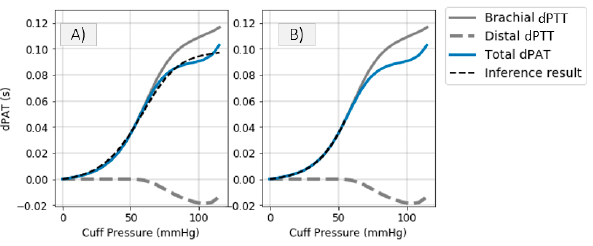
Figure 9. Inference of parameters a and c by ( A ) taking into account the entire dPAT recording, ( B ) discarding dPAT samples corresponding to cuff pressures greater than P dia .